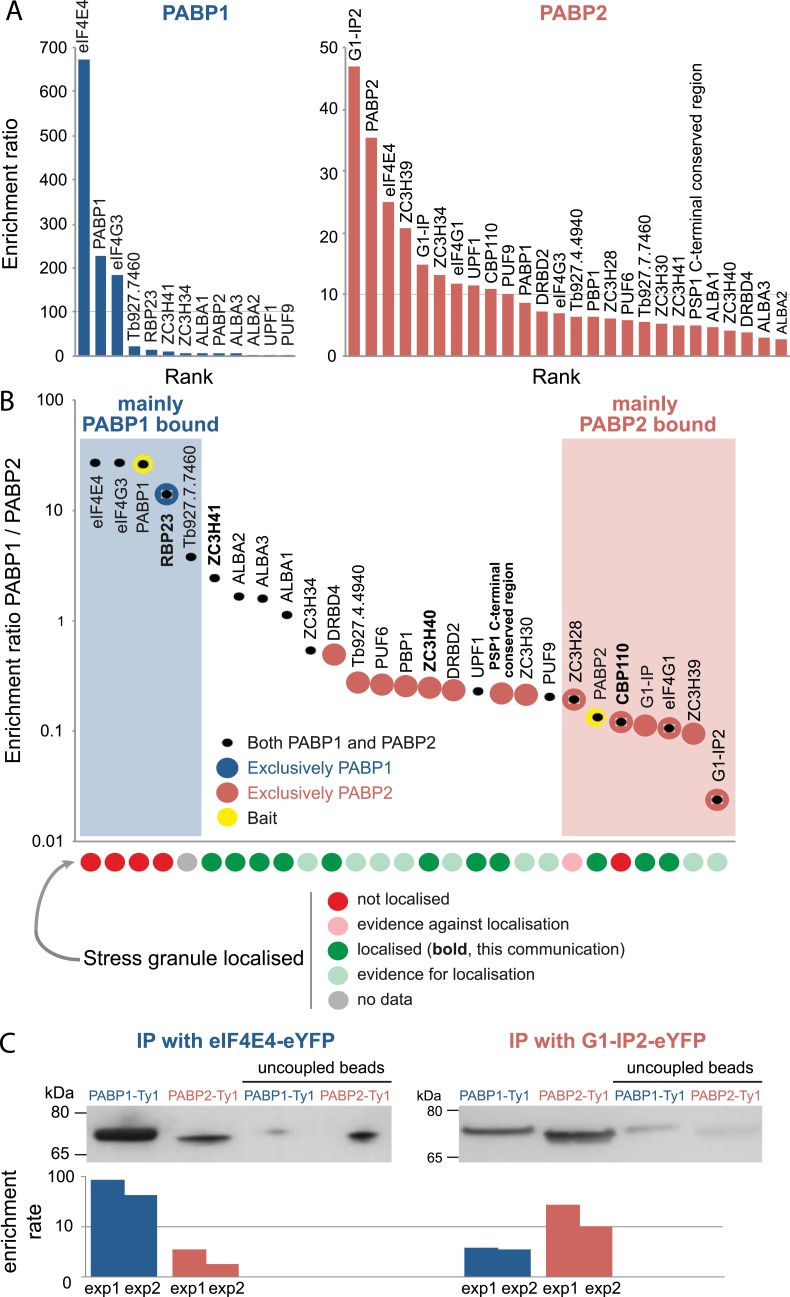
Proteins interacting with PABP1 and PABP2.A high confidence list of PABP interacting proteins was obtained by excluding proteins with an enrichment score less than two-fold in all four replicates; moreover, maximal one infinite ratio was tolerated. (A) Proteins co-precipitating with PABP1 (blue) or PABP2 (red) are shown sorted according to their average enrichment rates. Note the differences in scale on the y-axis between the two PABPs. (B) Differences between the interactomes of PABP paralogs; all 27 proteins that are enriched in either or both PABP pull-downs are ranked according to enrichment ratio PABP1/PABP2. Bait proteins are shown in yellow. Proteins unique to either PABP, defined by having an enrichment ratio <2 in the other PABP, are shown as large circles. Localisation to starvation stress granules is indicated for each protein (see S1G Table for references). Stress granule localisation information based on experimental data are shown in dark colours, other evidence (from TrypTag data [59]) is in lighter colours. (C) Reverse immunoprecipitations: eIF4E4 or G1-IP2 was expressed as an eYFP fusion protein together with either PABP1-4Ty1 or PABP2-4Ty1, all from their endogenous locus. eIF4E4 and G1-IP2 were precipitated from cryo-milled powders with recombinant anti-GFP Llama antibodies. Co-precipitated PABP proteins were detected with anti-Ty1 (BB2) monoclonal antibody. Beads without antibody were employed to calculate the enrichment factor. Data from two replicates (exp1 and exp2) are shown, and one representative blot.